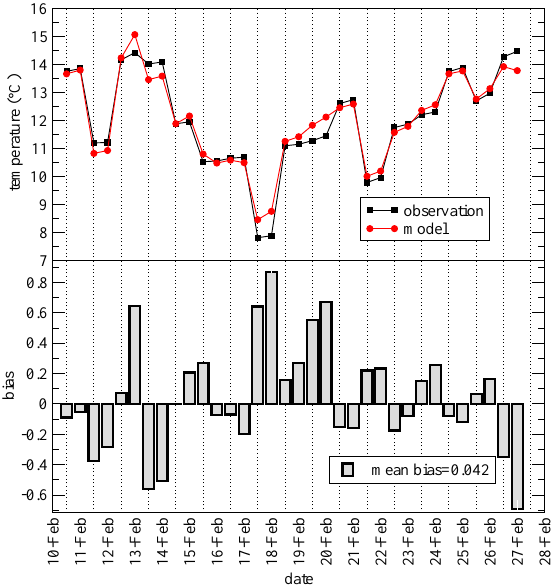
Fig. 8. Time series of diurnal variations of averaged SST (upper panel) and BIAS (lower panel) between model (red) and observa- tions (black). Note that the observation areas are different for each date. This is a result of changes in satellite coverage from day to night. See the next figure for